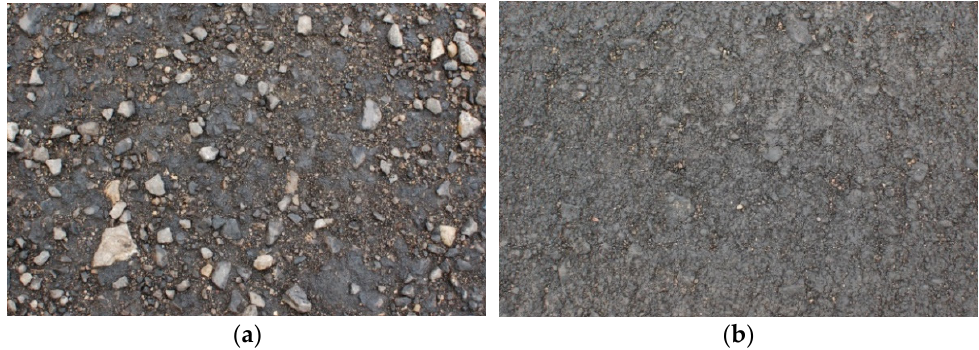
Figure 8. Trial road sections: ( a ) “gravel”—cold rolled destructed asphalt material and ( b ) hot, recycled in 120 °C, RAP of the same material.